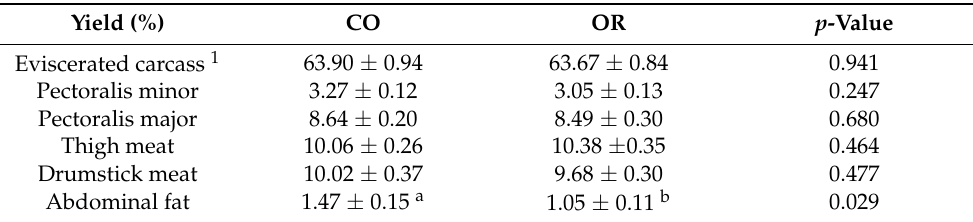
Table 4. Effects of organic raising system on carcass composition of Korat chicken at 84 d of age (mean ±